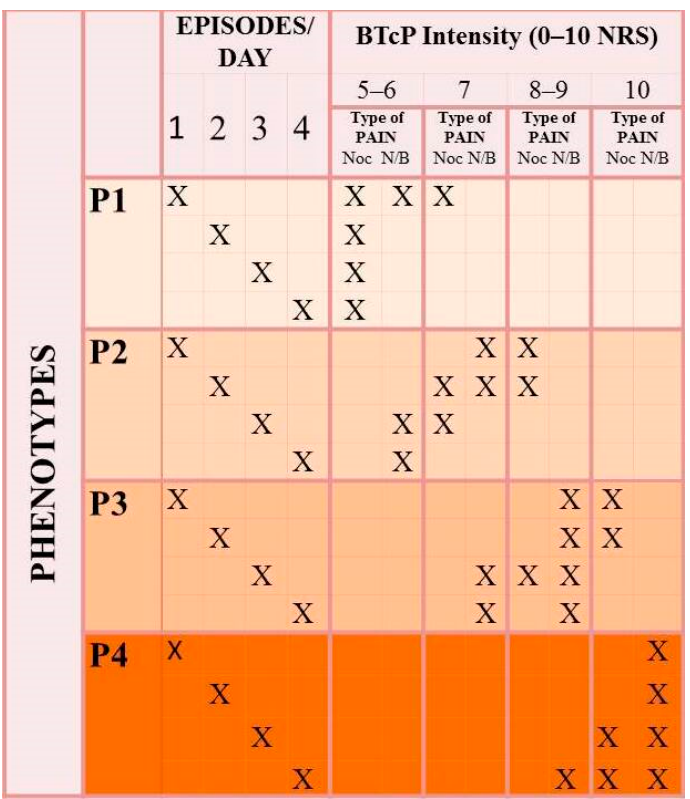
Figure 4. Phenotypes of non-predictable breakthrough cancer pain. Four phenotypes (from P1 to P4) are described according to the pain intensity, the number of episodes a day, and the type of pain. Abbreviations: NRS—numerical rating scale; Noc—nociceptive; N/B—neuropathic or both.